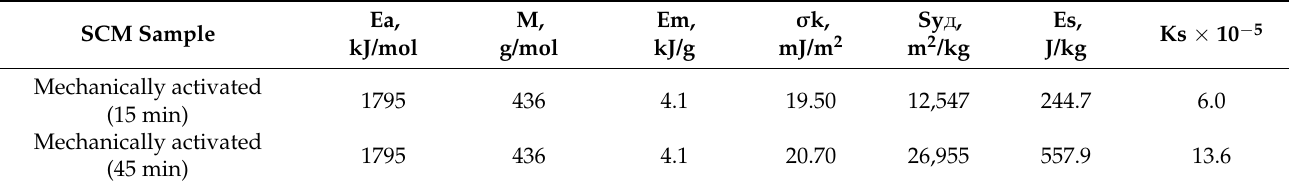
Table 1. Properties of SCM samples